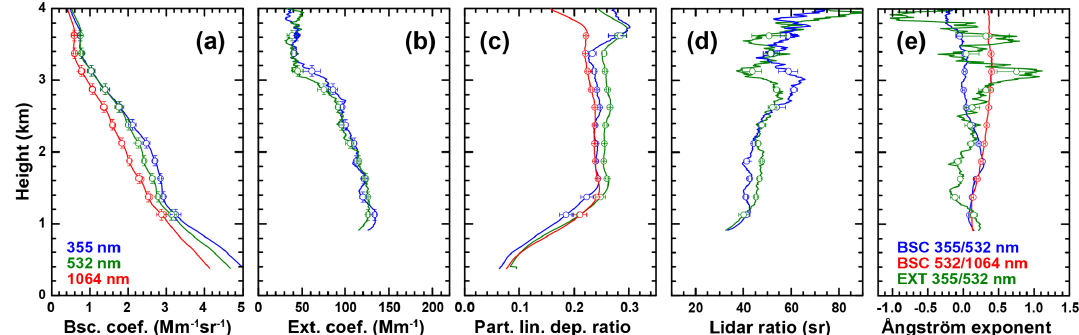
Figure 2. BERTHA measurement from 23:10 to 02:10UTC on 20–21 June 2014 during SALTRACE in terms of (a) backscatter coefficient, (b) extinction coefficients, (c) particle linear depolarization ratios, (d) lidar ratios, and (e) backscatter- and extinction-related Ångström exponents. Colours mark the corresponding wavelengths or wavelength pairs. The measurement is representative for pure mineral dust conditions (Haarig et al., 2017a). The coloured circles mark the height averages used to compile the eight variations of input data sets for our data inversion (Table 2). Error bars refer to the standard deviation of the height average. Further details on this measurement are given